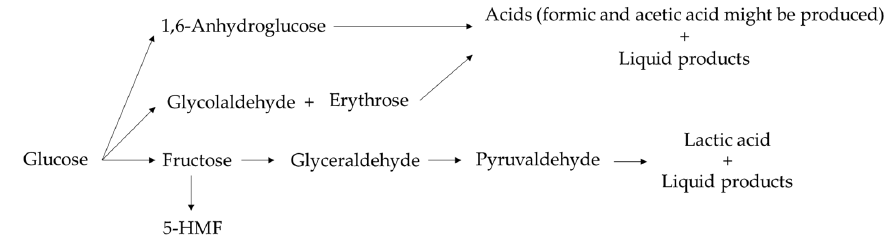
Figure 3. Mechanisms of oxidation of glucose.